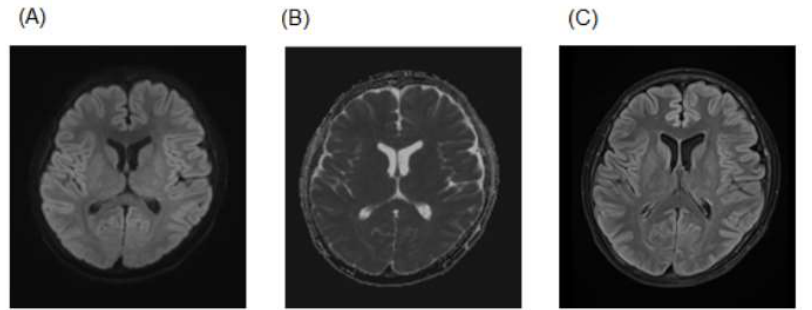
Figure 2. ( A ) DWI, ( B ) ADC map and ( C ) FLAIR images on the 10th day. The findings seen on admission had been obscured.